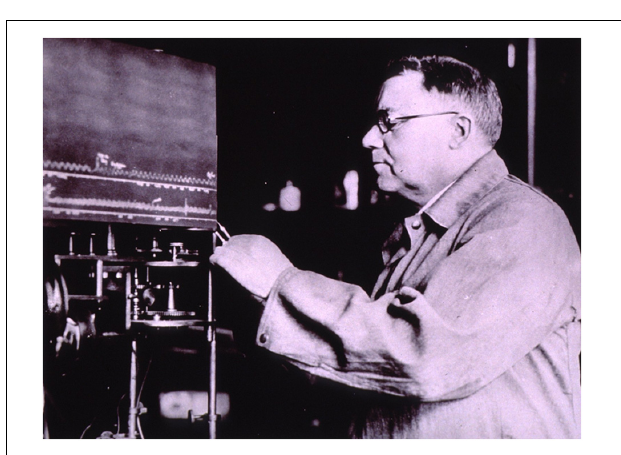
FIGURE 3 | Photograph of Walter B. Cannon (1871–1945). He built upon the work of Claude Bernard and coined the word homeostasis to describe a self-regulating process by which biological systems maintain stability while adjusting to changing conditions. Source: National Library of Medicine (the history of medicine public domain image